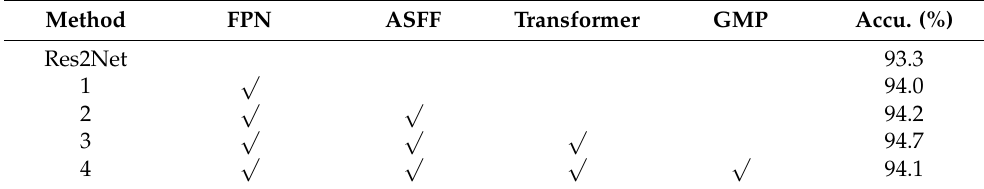
Table 3. Ablation experiment results of